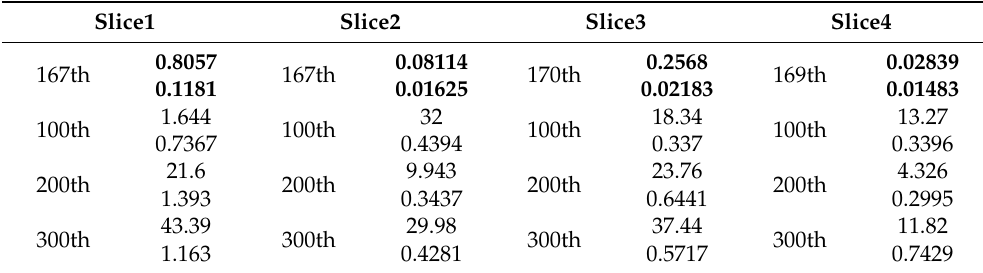
Table 3. Backscattering amplitude comparison: target point and surrounding point selected in Figure 13 * (100th, 200th, 300th angle as comparative analysis). Slice1 Slice2 Slice3